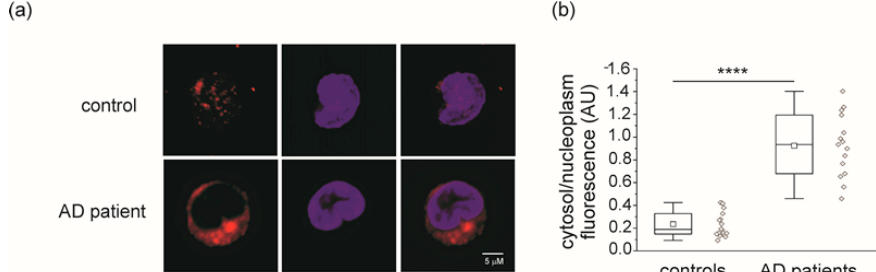
Figure 3. Cytoplasmic accumulation of CLIC1 protein in monocytes from AD patients. ( a ) Representative confocal images of single isolated monocytes (blue nuclei) from control subjects (top) and AD patients (bottom) showing CLIC1 protein distribution (red). ( b ) Analysis of the cytoplasm/nucleoplasm CLIC1 fluorescence ratio in isolated monocytes from 18 control individuals (0.235 ± 0.027) and 15 AD patients (0.925 ± 0.071) (****, p < 0.0001, unpaired t test).